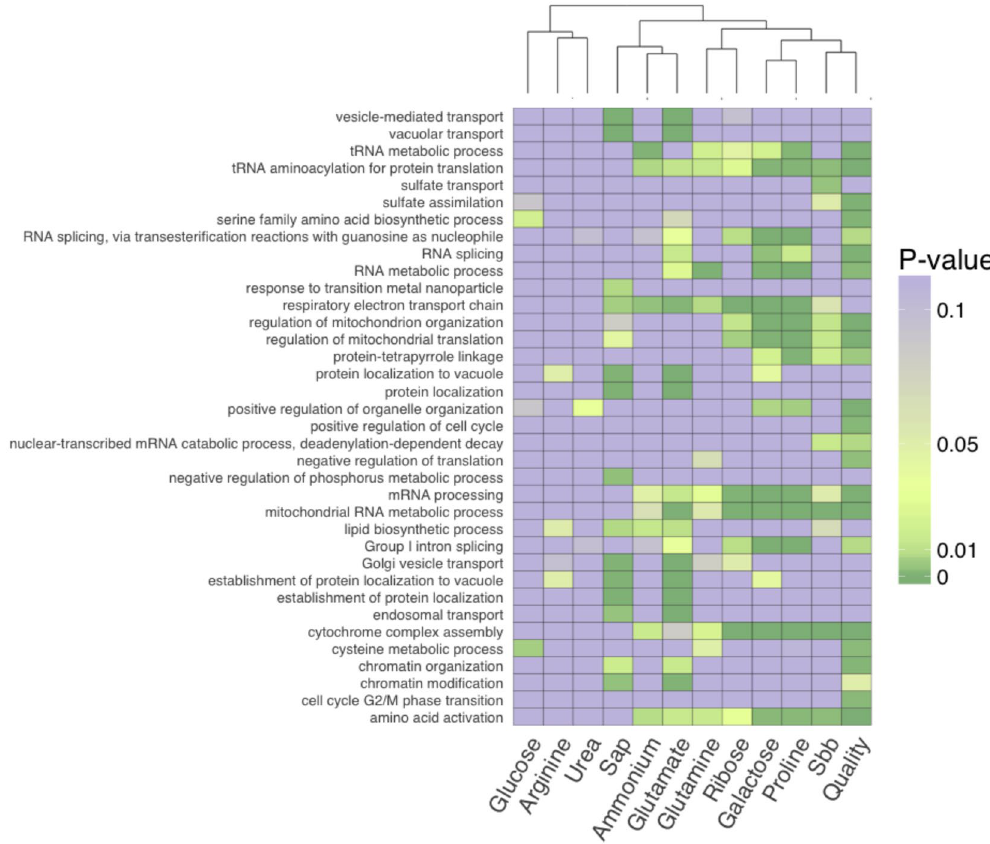
Figure 3. Heatmap of the most enriched biological processes in Maple sap, Quality and S bb lists (P-value < 0.01) alongside enrichments for genes involved in utilization of particular substrates 37 . We excluded the enrichments related to growth on allantoin common between our assay and the VanderSluis experiments (P-value <